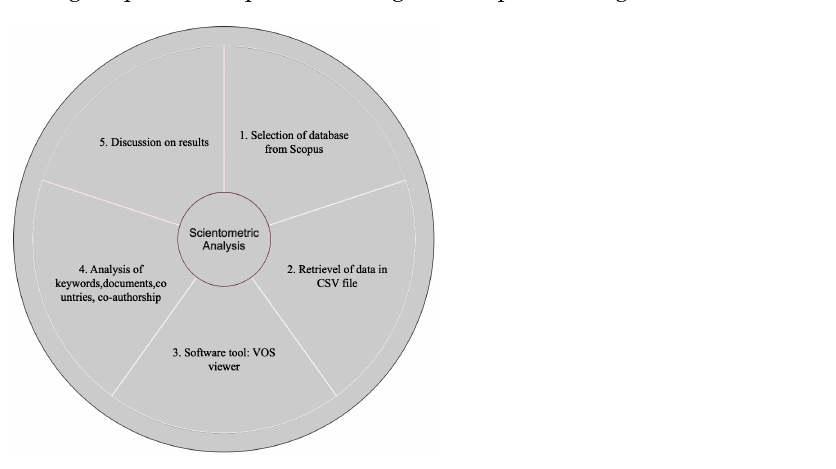
Figure 1. Sequence of scientometric analysis for drought. CSV: Cmma-separated values.